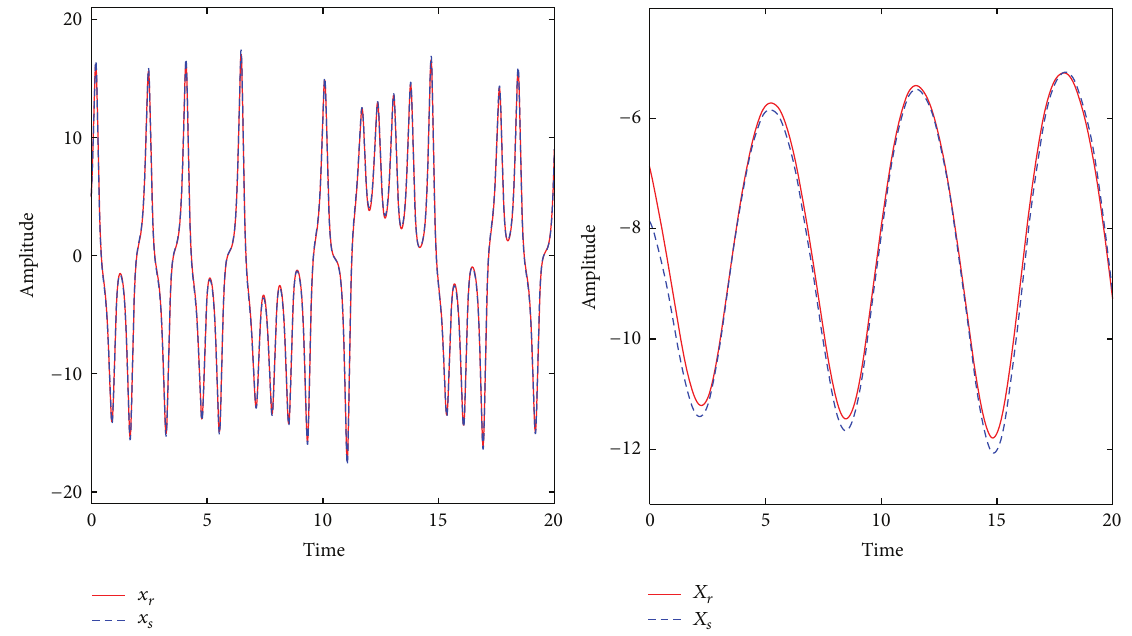
Figure 10: Original trajectory (in red) and pseudoorbit (in blue) for fast 𝑥 and slow 𝑋 variables for 𝑐 0 = 0.01